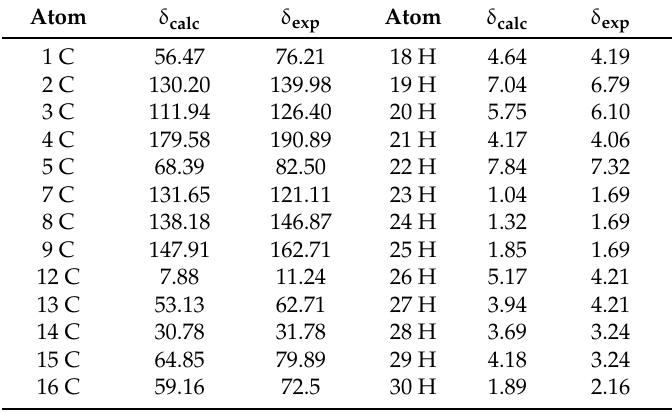
Table 5. Calculated and experimental NMR chemical shifts of compound 4